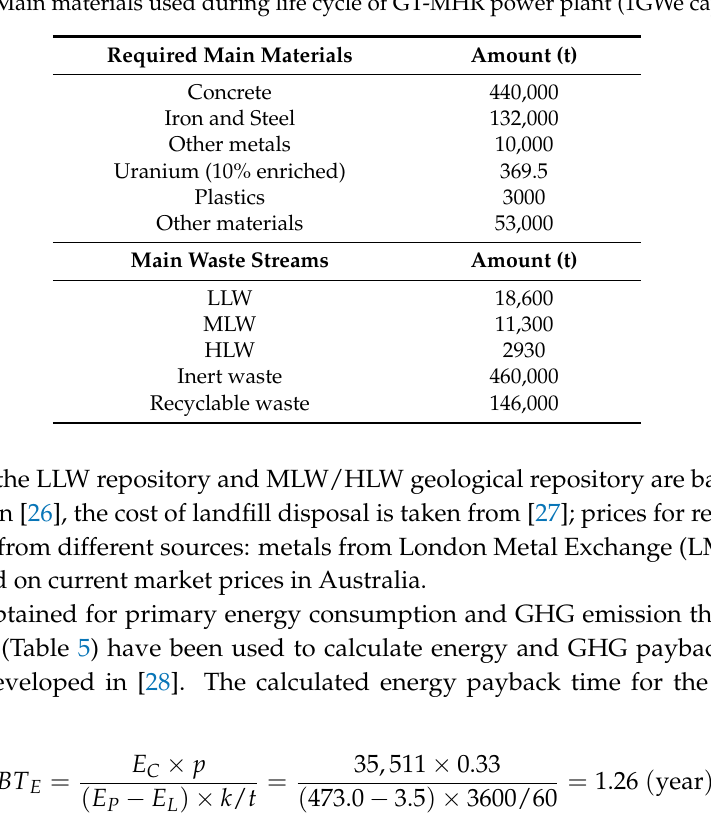
Table 4. Main materials used during life cycle of GT-MHR power plant (1GWe